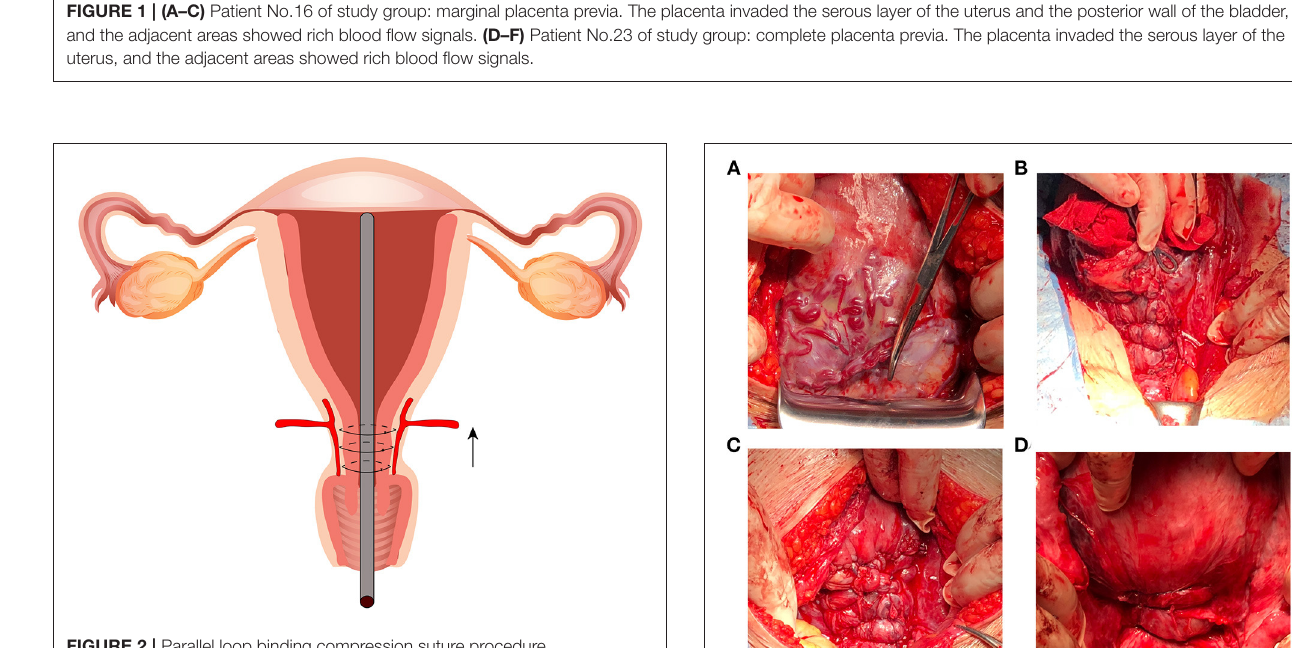
FIGURE 2 | Parallel loop binding compression suture procedure.